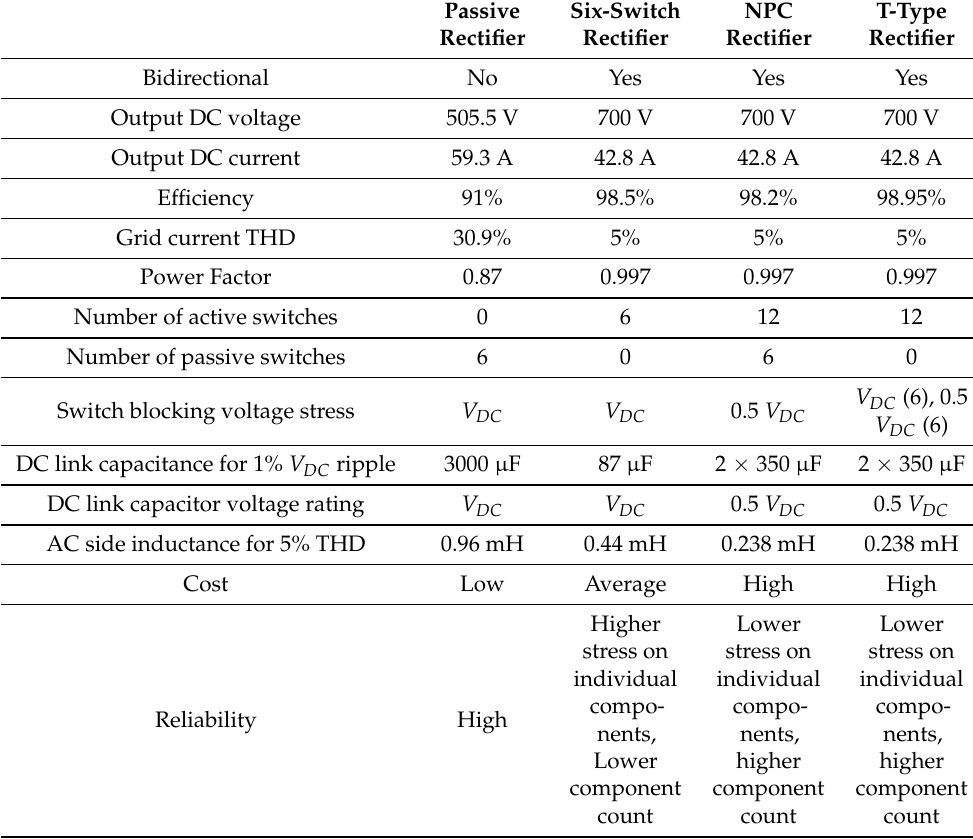
Table 2. Comparison of rectifier